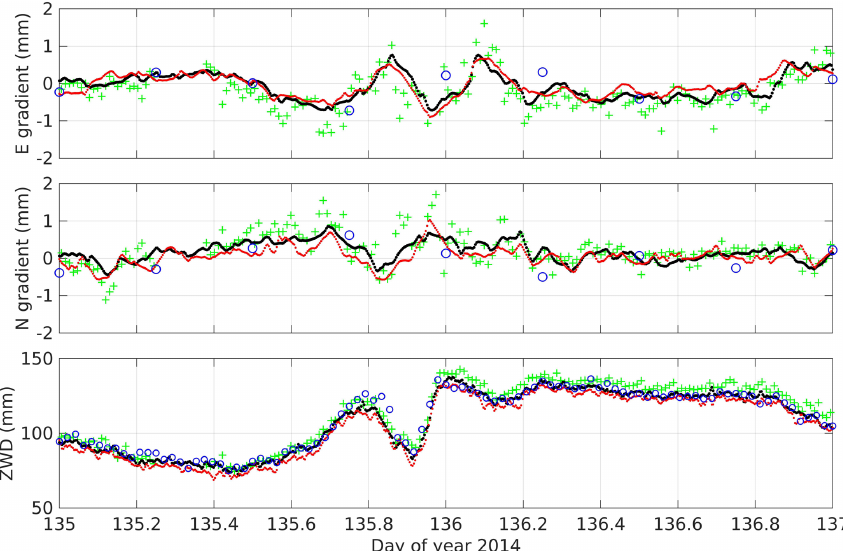
Figure 16. Zoom in on the time series in Fig. 15. The symbols are as before: VLBI gradients (blue circles), GPS gradients for ONSA (red dots) and ONS1 (black dots), and WVR (green